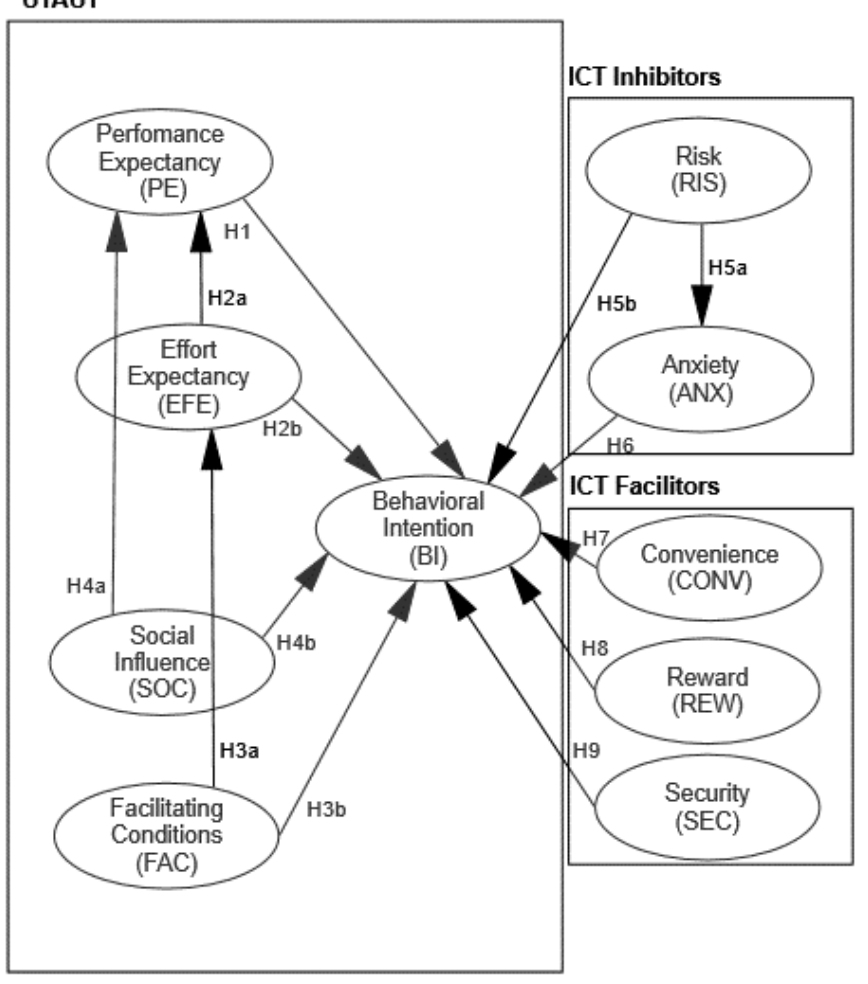
Figure 1. Hypothesized research model.